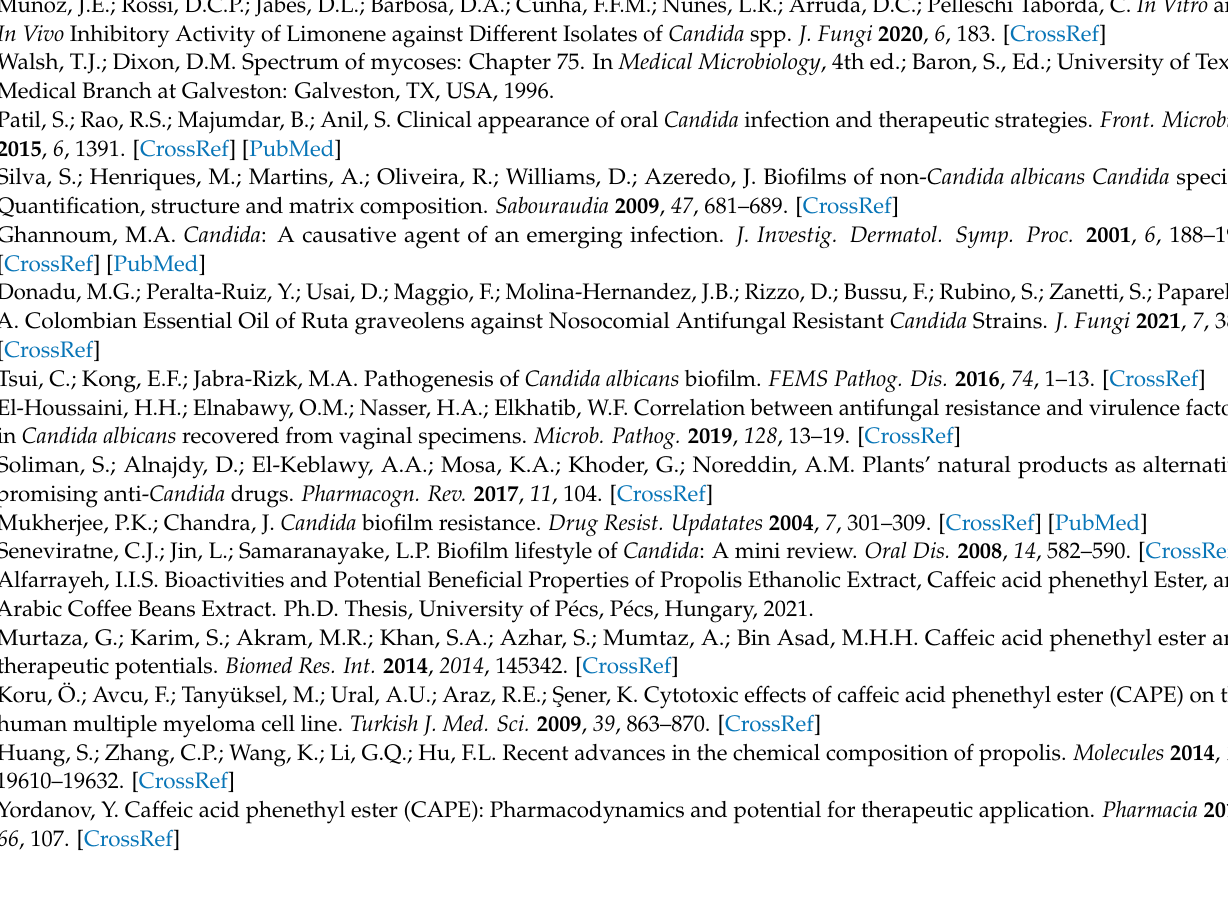
of CAPE, Figure S6: Representative flow cytometry scatter plot showing apoptosis of C. glabrata SZMC 1374 treated with 12.5 µ g/mL of CAPE, Figure S7: Representative flow cytometry scatter plot showing apoptosis of C. glabrata SZMC 1378 treated with 12.5 µ g/mL of